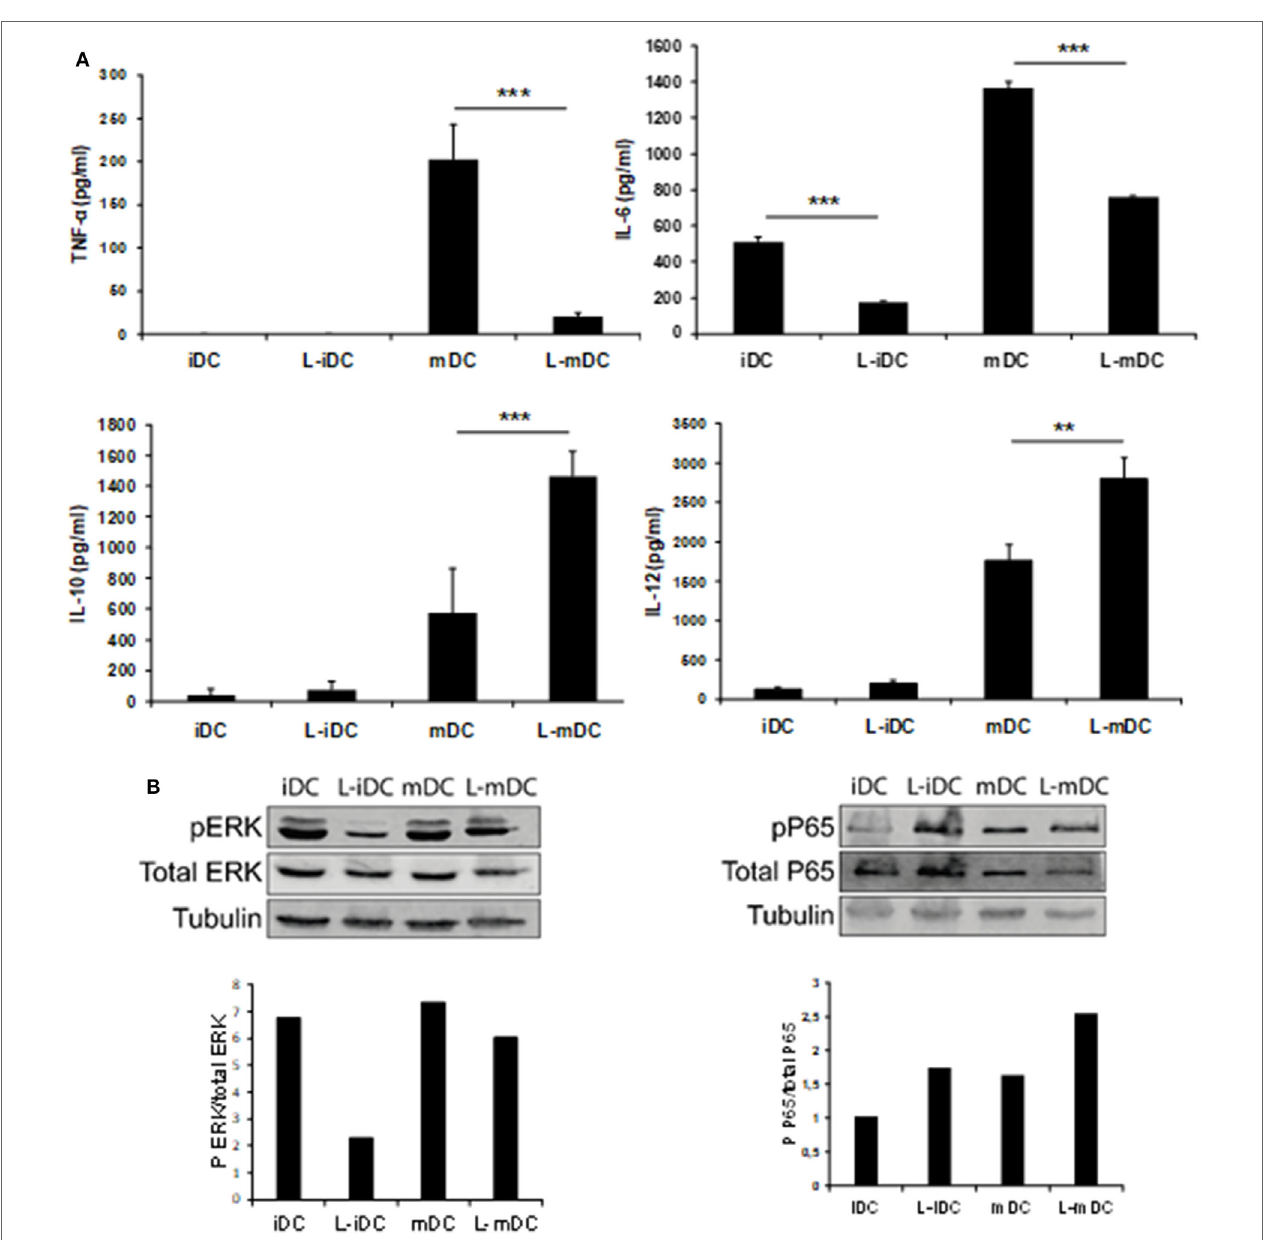
FigUre 5 | L-mDCs showed impaired production of IL-6 and TNF- α as well as enhanced secretion of IL-10 and IL-12. (a) Enzyme-linked immunosorbent assay quantification of secreted cytokines by dendritic cell cultures stimulated with LPS for 48 h. Average cytokine concentration from four independent experiments ± SDs is shown (** p < 0.03; *** p < 0.01). (B) Western blotting of whole cell lysates from immature dendritic cells (iDCs), matured DCs (mDCs), L-iDCs, and L-mDCs. The blots were probed with antibodies to total ERK, phospho-ERK, total NF κ B, or phospho-NF κ